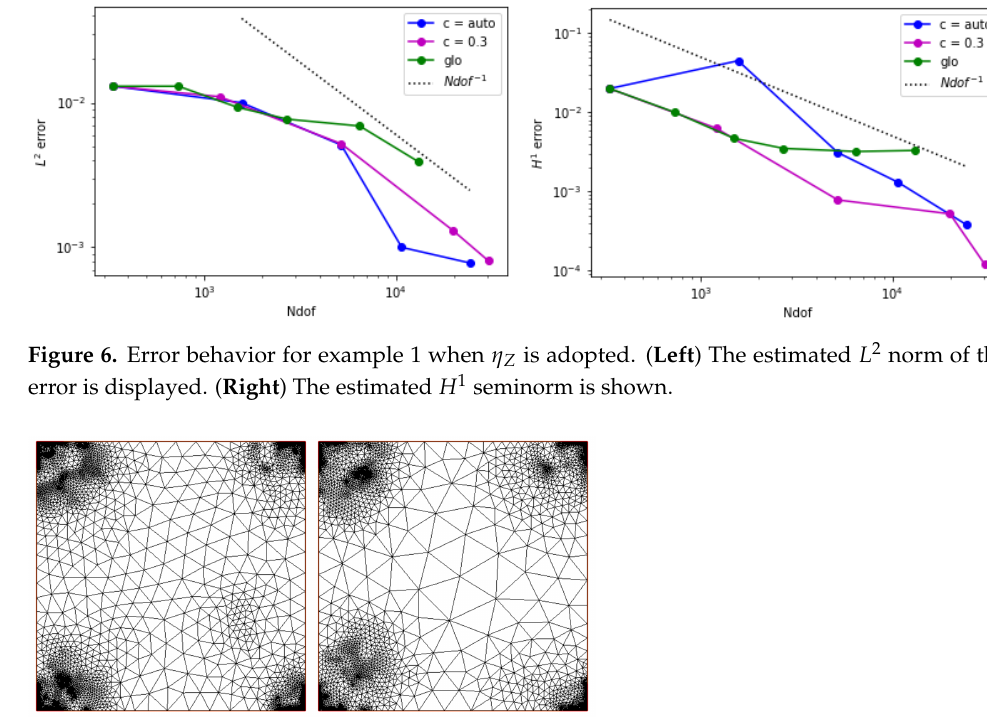
Figure 7. Resulting meshes for example 1 and η N error estimator. ( Left ) The final mesh obtained by setting c = auto . ( Right ) The final mesh obtained by setting c = 0.3. Table 3. L 2 and H 1 error for example 1 by using the η N error